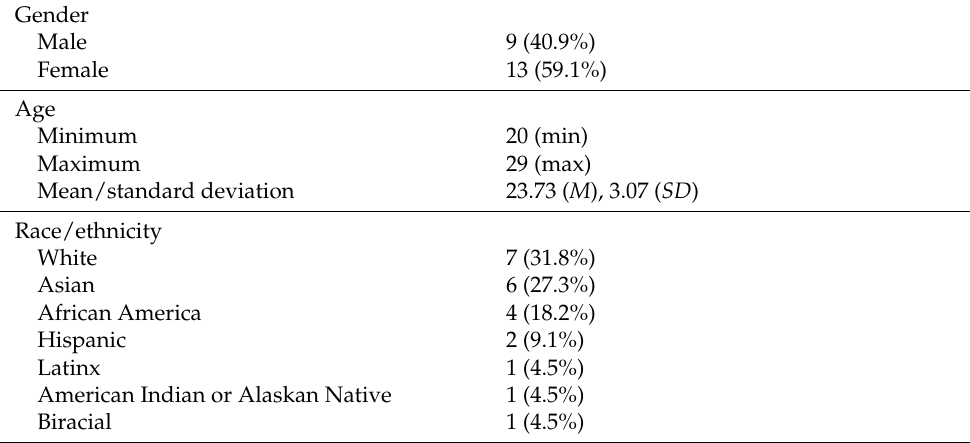
Table 1. Participant demographics.